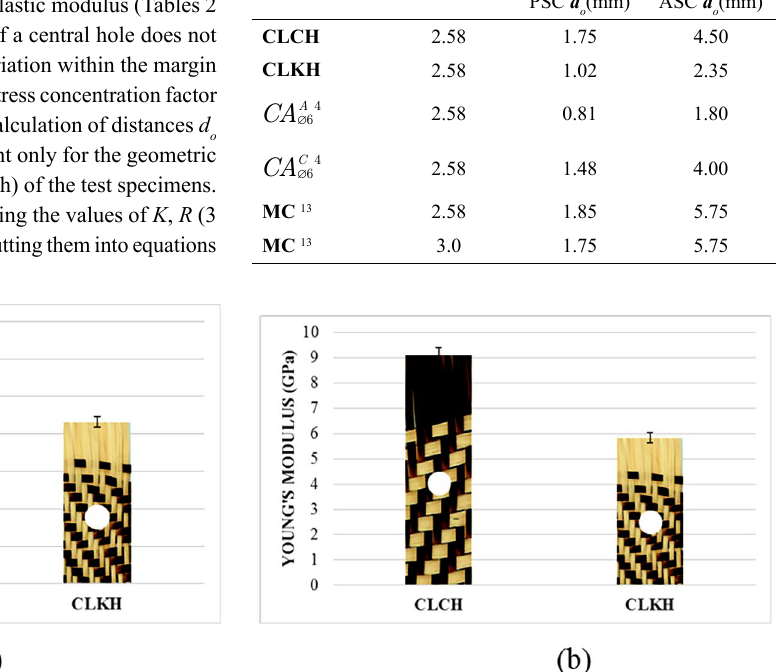
between test specimens CLCH and CLKH can also be assessed based on strength and residual modulus, that is, limits and elastic properties.